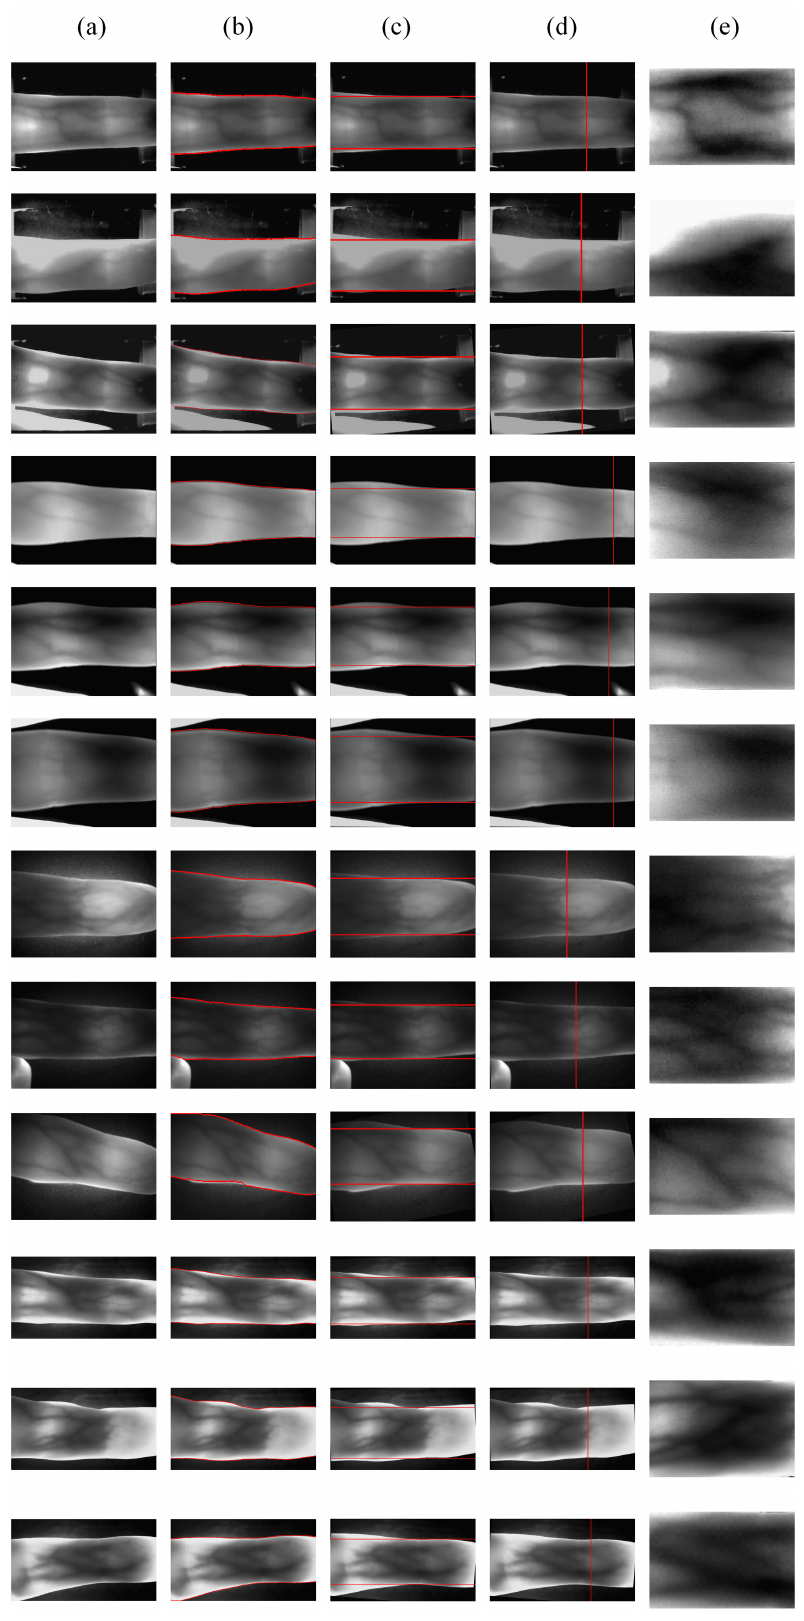
Figure 10. ROI extraction using the proposed method. ( a ) original images; ( b ) finger edges; ( c ) final horizontal reference lines positioning; ( d ) distal joints positioning; ( e ) extracted